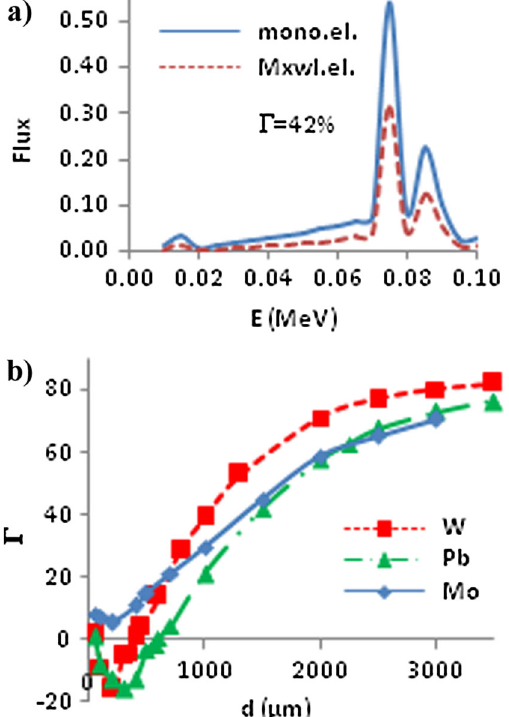
FIG. 8. (a) A comparison of the x-ray fluxes obtained by the q -monoenergetic and the q -Maxwellian electron distributions for Pb in d ¼ 1500 (cid:5) m , showing 42% percentage of increase by using the former compared with the latter. (b) (cid:1) , percentage of increase of the x ray produced by the q -monoenergetic electrons compared with the q -Maxwellian electrons in different thicknesses for three targets of Mo, W, and Pb.